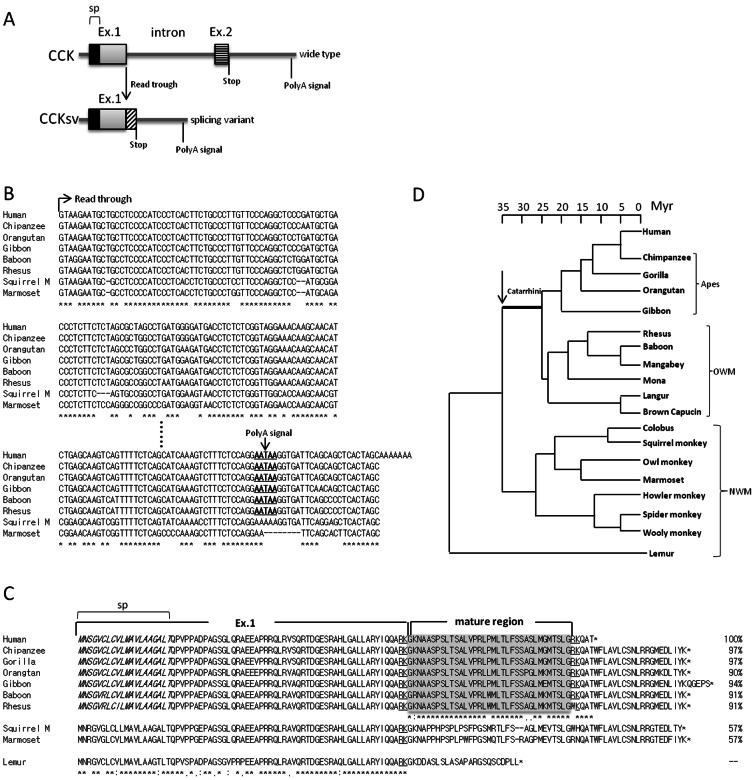
CCKsv originated by including a portion of intronic sequence of the CCK gene and evolved in the Catarrhini lineage.(A), Gene structure of CCK and CCKsv. Human CCK gene has two exons and one intron. Wild type CCK protein is encoded by exon1 and exon2 with exon1 containing the signal peptide (sp) and exon2 containing the mature peptide region (stripped bar). CCKsv is encoded by exon1, followed by a read through into the intron region, leading to the generation of novel mature region (hatched bar), followed by a stop codon and a new poly-adenylation signal. (B), Alignment of CCKsv read though sequences in diverse primate species. Sequences encoding the putative poly-adenylation signal are in bold and underlined. Full nucleotide sequence alignment is shown in Supplementary Fig. S7. (C), Alignment of predicted CCKsv protein sequences in primates. Genomic DNA sequences found in NCBI and UCSC genome databases were translated and deduced protein sequences aligned by the ClustalW program [36]. Signal peptide (sp) is in italic. Putative mature regions of CCKsv were shaded and proteolytic processing signal underlined. Similarity to the human mature peptide region is shown as percentages on the right side. (D), Phylogenetic tree of the primate species. Phylogenetic relationships among different primate species are based on previous studies [37], [38] with the divergence times [35] indicated. An arrow denotes the time when the CCKsv emerged.